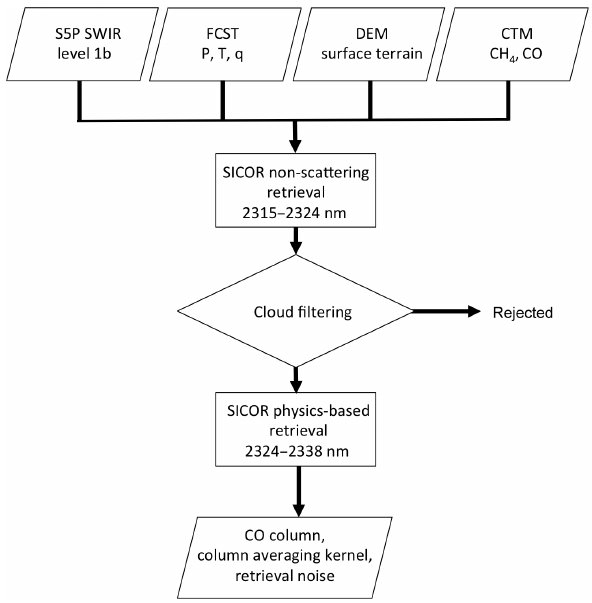
Figure 2. Flowchart of the SICOR